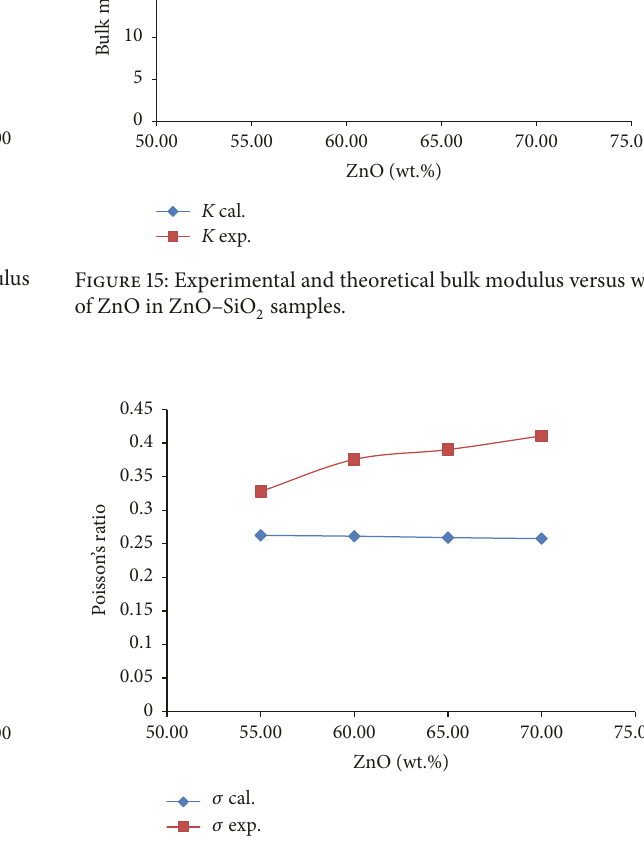
Figure 16: Experimental and theoretical Poisson’s ratio versus wt.% of ZnO in ZnO–SiO 2